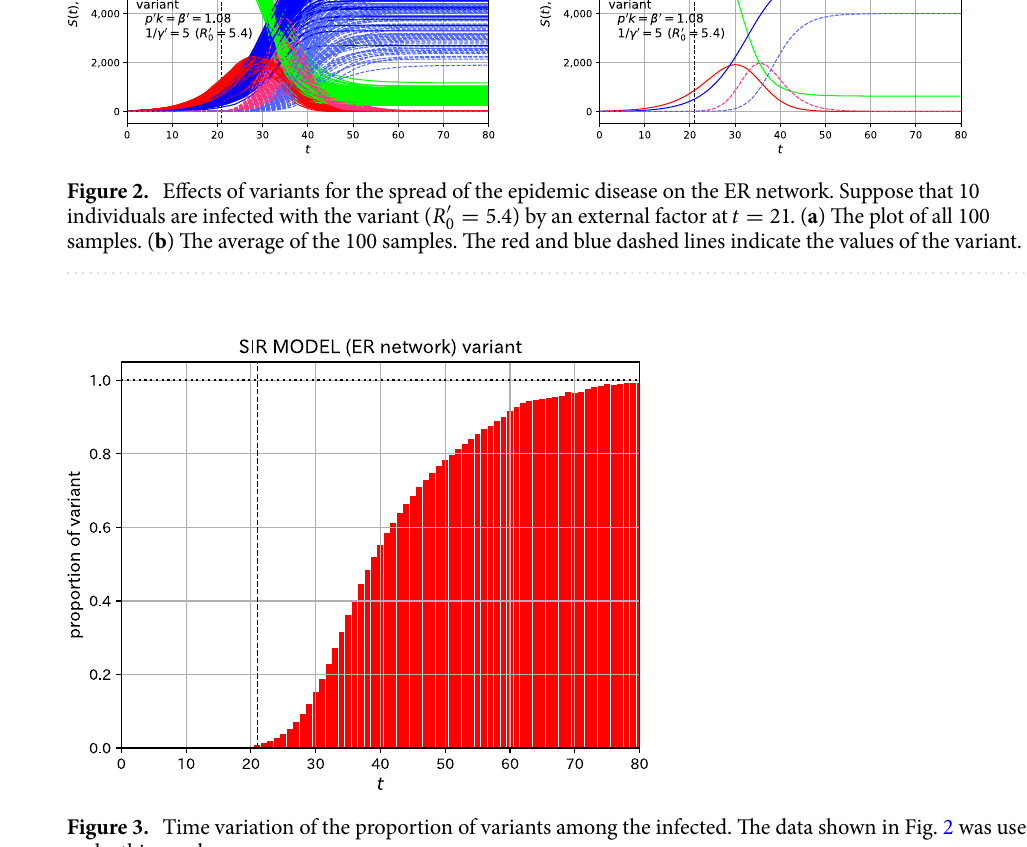
Figure 3. Time variation of the proportion of variants among the infected. The data shown in Fig. 2 was used to make this